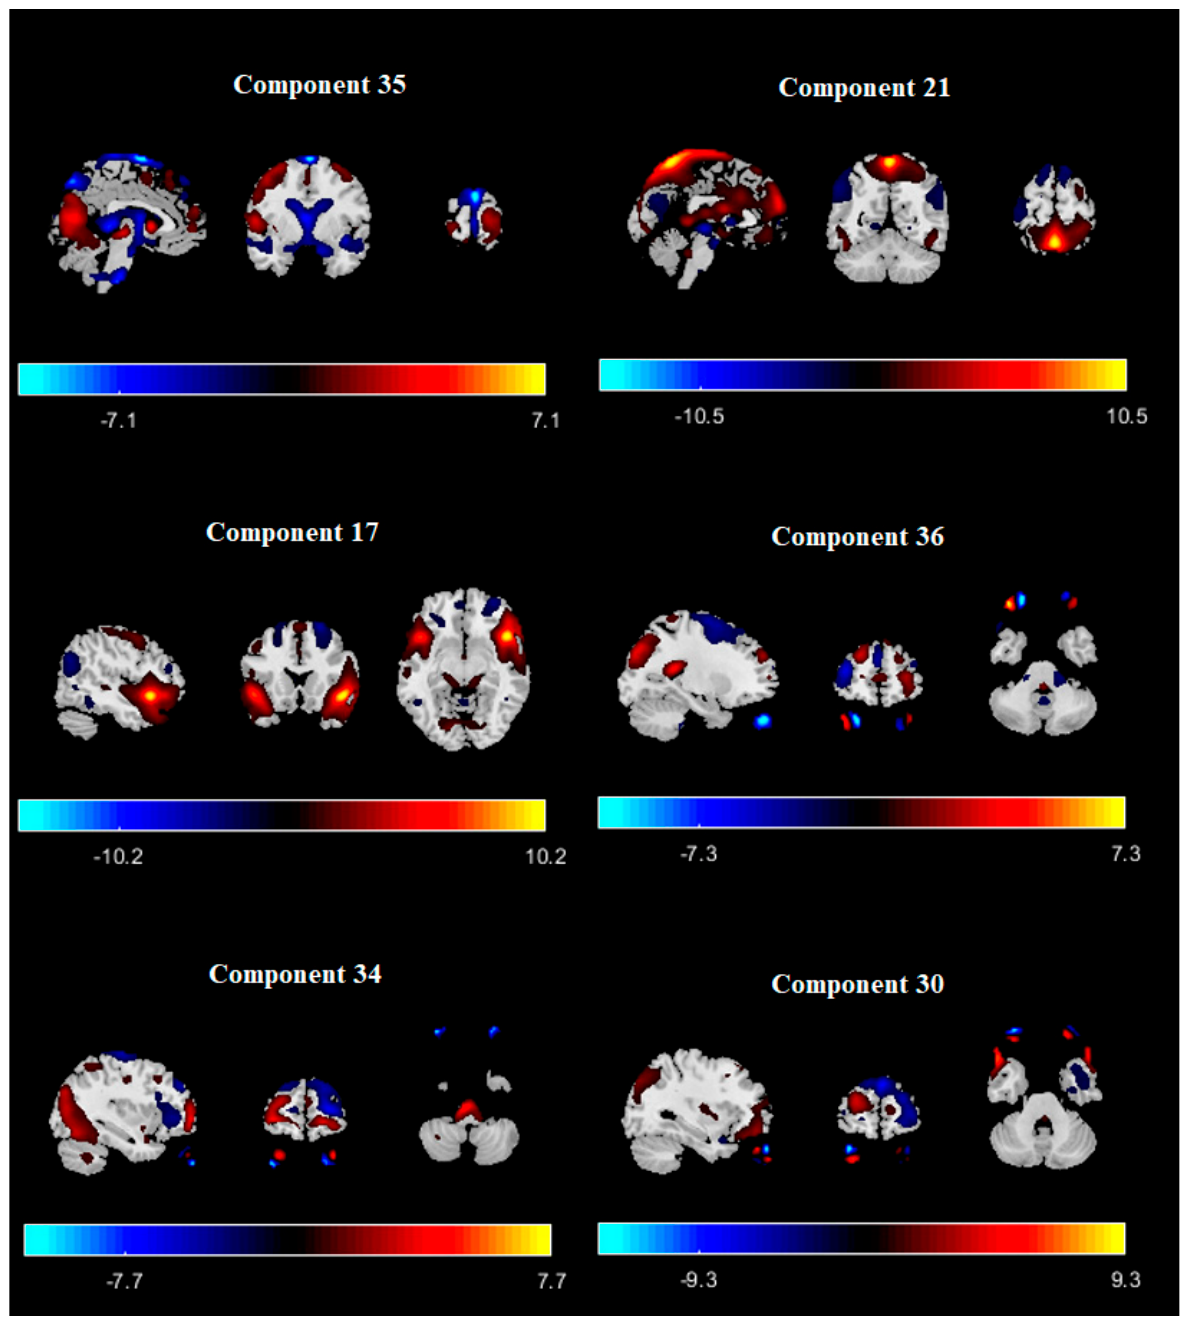
Figure 2. Extracted ICNs with proposed ICA algorithm .